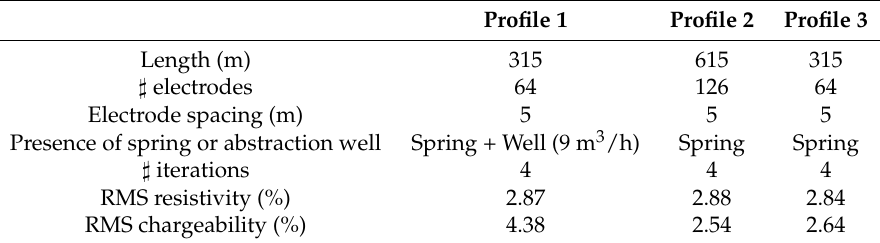
Table 2. Acquisition and inversion parameters for the three 2D